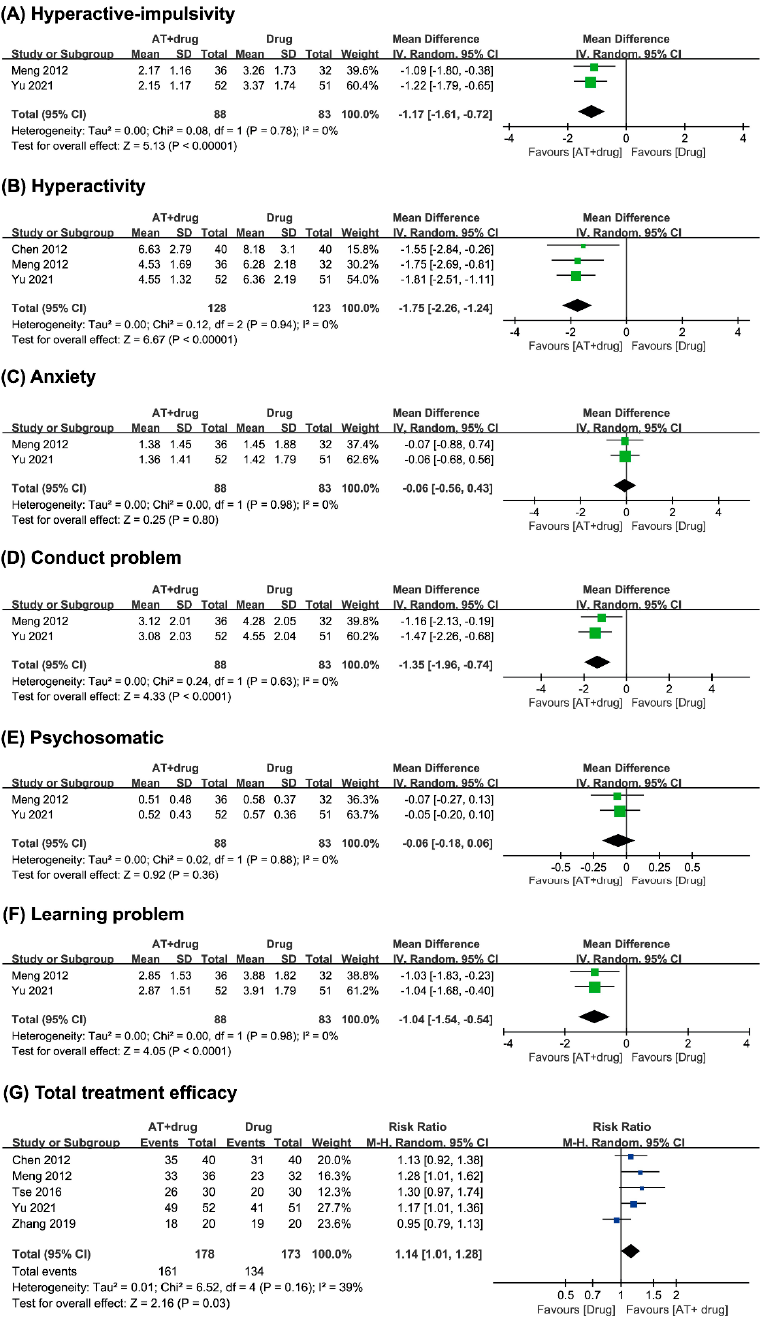
Figure 4. Forest plot of ( A ) hyperactivity–impulsivity, ( B ) hyperactivity, ( C ) anxiety, ( D ) conduct problems, ( E ) psychosomatic, ( F ) learning problems, and ( G ) total treatment efficacy of acupuncture plus conventional medicine vs. conventional